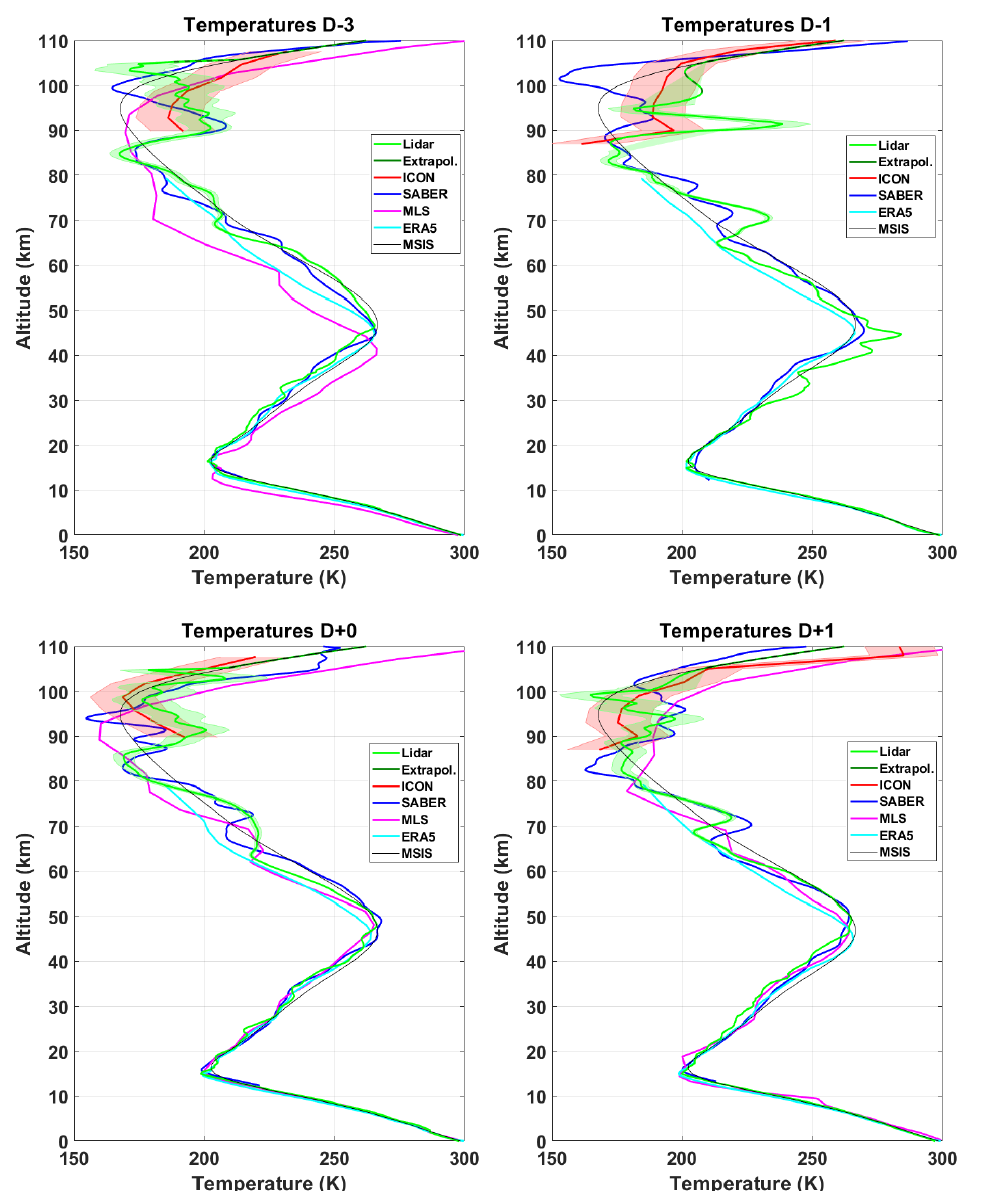
Figure 4. Nightly average temperature profiles made by the Monge lidar (green), extrapolated Monge lidar (dark green), ICON (red), SABER (blue), MLS (magenta), ERA5 (cyan), and MSIS